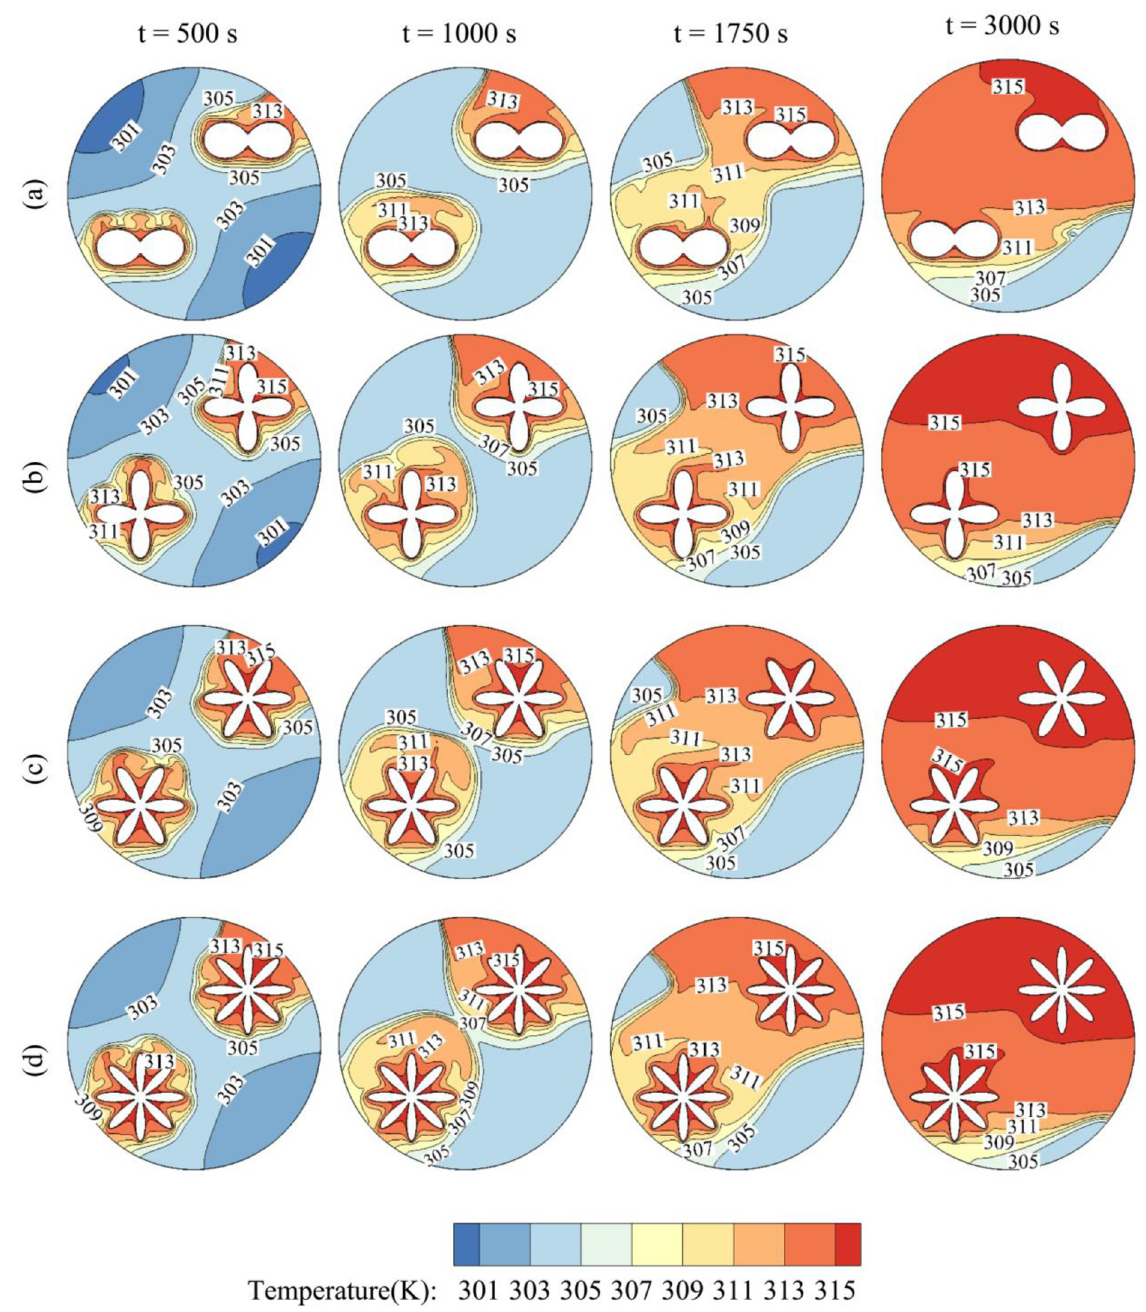
Fig 8. The contours of Temperature and the effects of the number of petals of the quasi-petal heat pipe on contours of Temperature. (a): Λ = 2; (b): Λ = 4; (c): Λ = 6; (d): Λ = 8 when r d = 0.6 r s , A = 0.15 r s , and η = π /4. increase of the contact between the inner hot tube and the surrounding PCM when the num- ber of petals is increased. The effect of the radius of the base circle of the inner pipe, r , on the development of tem- d perature contours with time is illustrated in Fig 10. r represents the distance between the two d branches of the inner tube, and reducing r shifts the two branches of the tube towards the d